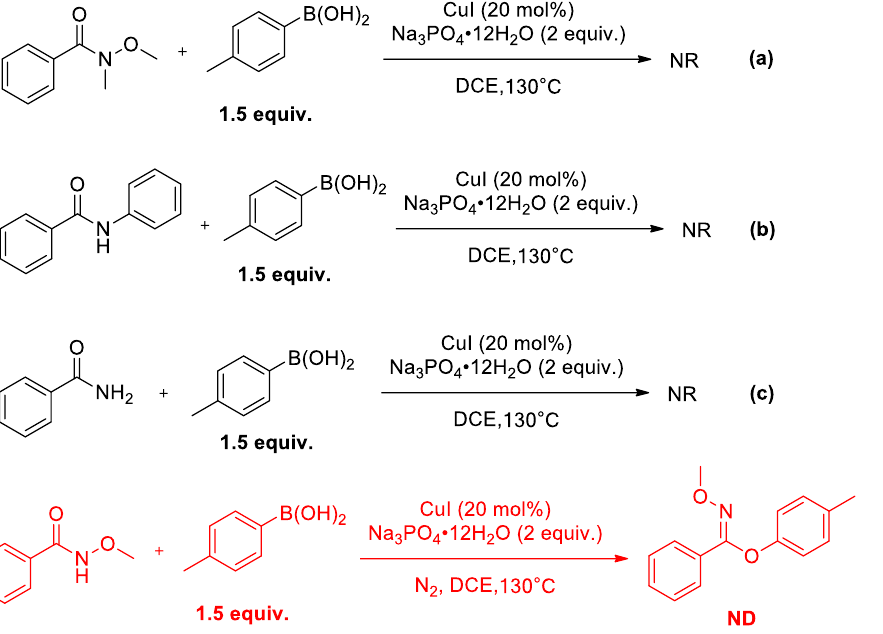
Figure 1. Plausible mechanism of the copper-catalyzed C-O coupling reaction.